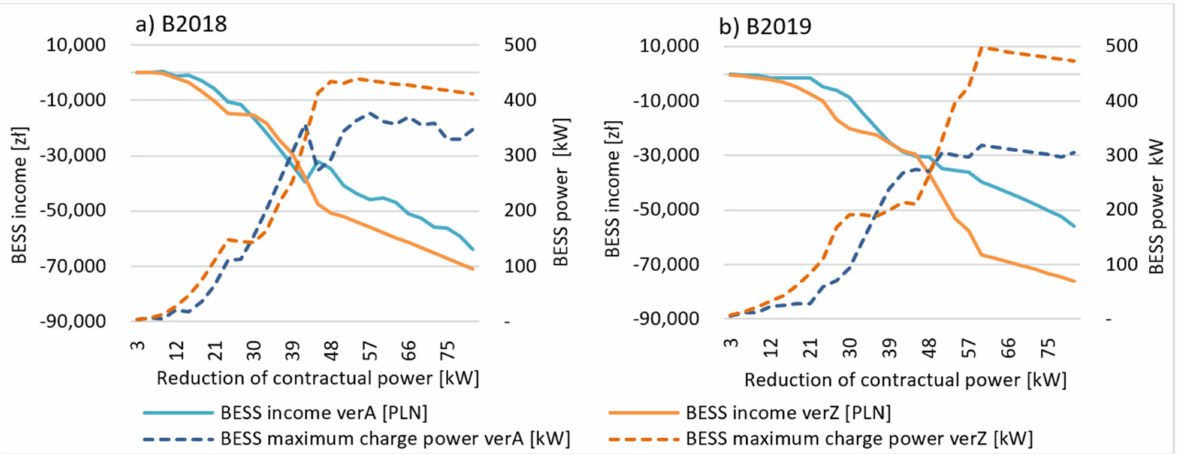
Figure 8. BESS income and BESS charging power as a function of contractual power for enterprises ( a ) B2018 and ( b ) B2019.